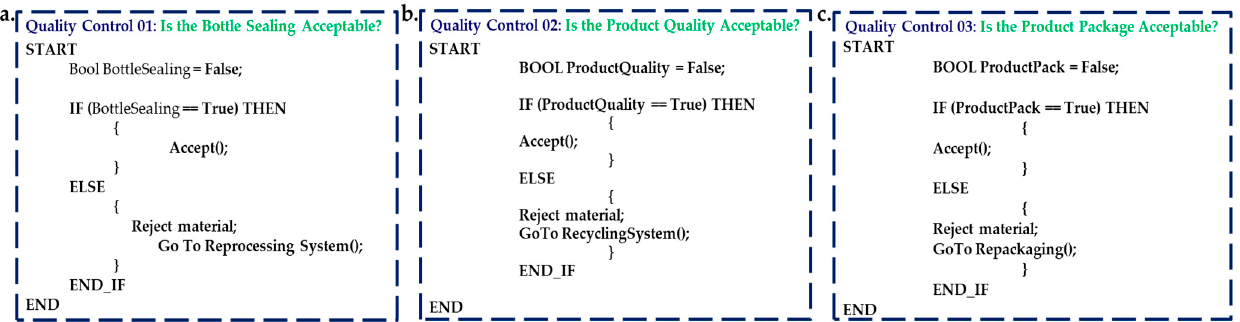
Figure 11. ( a ). Quality Control#01; ( b ). Quality Control#02 and ( c ). Quality Control#03 as a Pseudo-code.